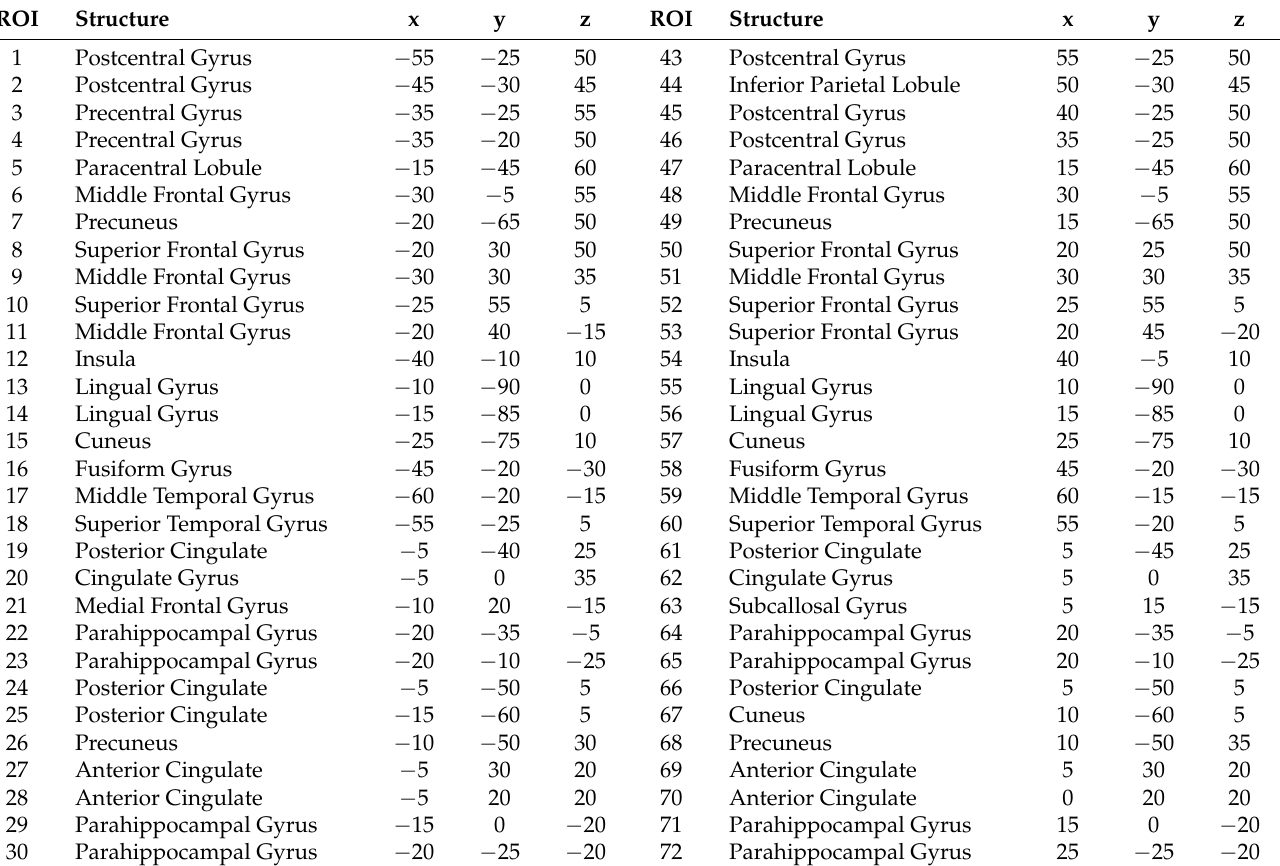
Table 2. MNI coordinates of the 84 regions of interest (ROIs) from cerebral cortex for the analysis of EEG functional